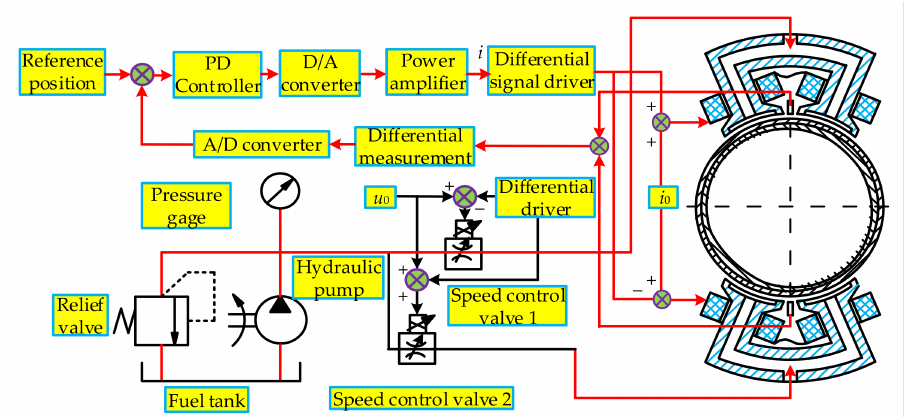
Figure 5. Regulating principle of the radial single-DOF system.